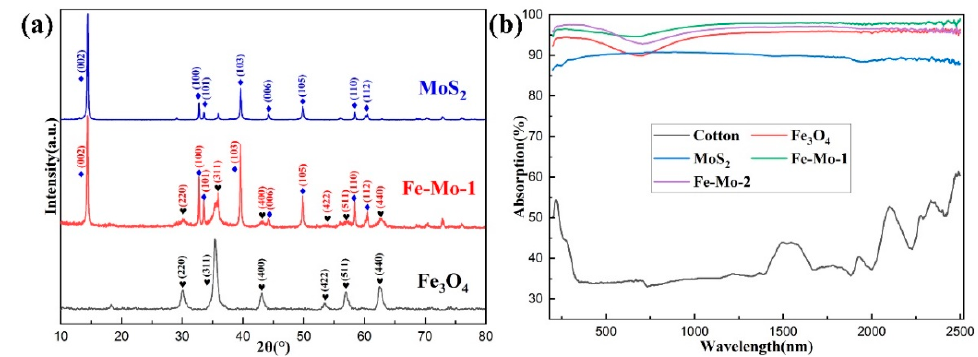
Figure 2. ( a ) XRD peaks of Fe 3 O 4 , MoS 2 , and Fe-Mo-1. ( b ) Optical absorption spectra of cotton, Fe 3 O 4 , MoS 2 , Fe-Mo-1, and